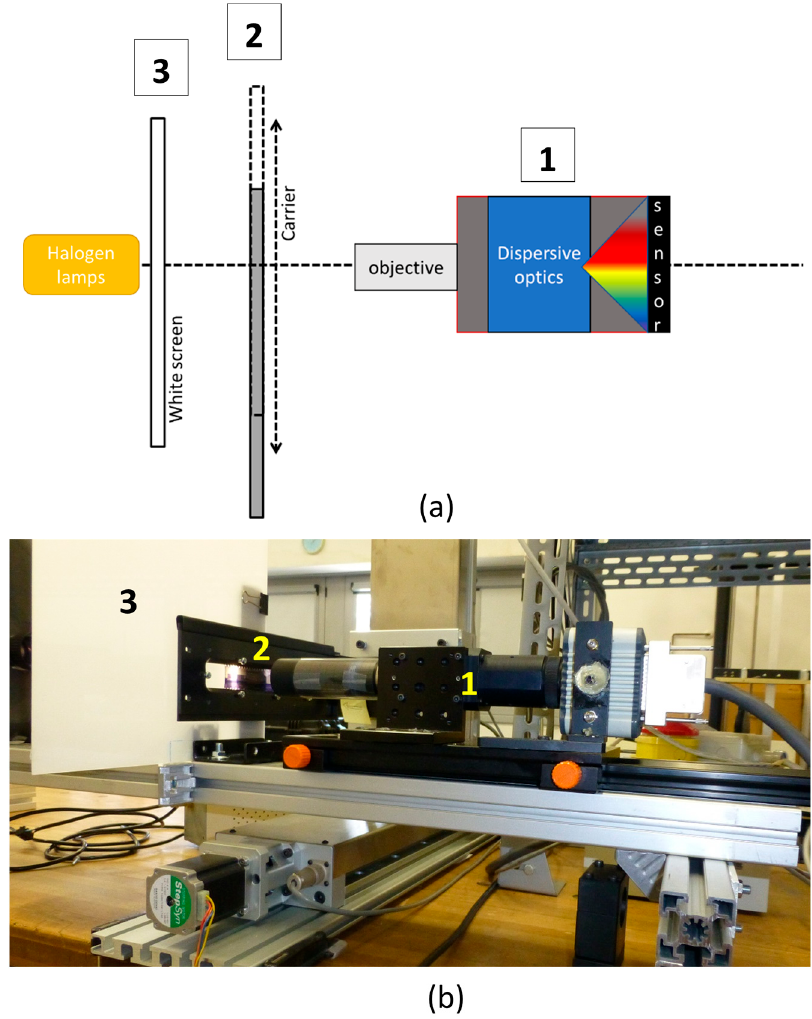
Figure 1. ( a ) Scheme of the setup and modules of the HSI transmittance scanner: the optical-spectrographic head (1), the automated scan strip carrier (2) and the screen of the illumination stage (3); ( b ) The three modules in ( a ) view of the prototype of the Transmittance IFAC-CNR HSI Scanner. The adopted configuration is intended to fully frame the vertical dimension of